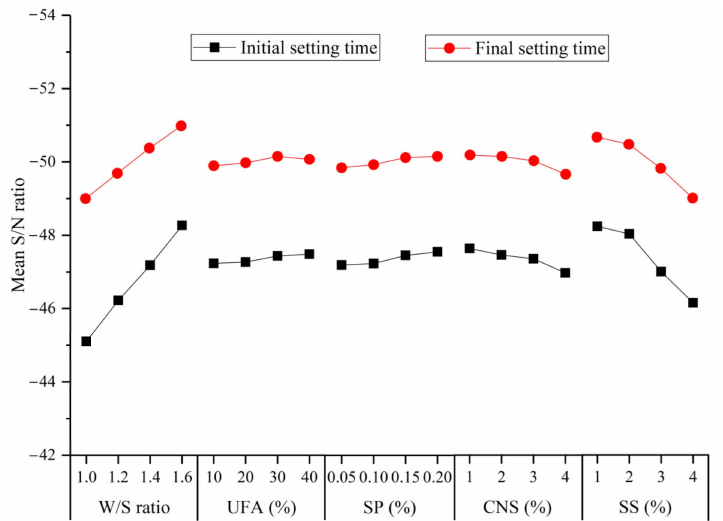
Figure 11. Mean S/N ratio values of the initial and final setting time of the UC-based slurry for different